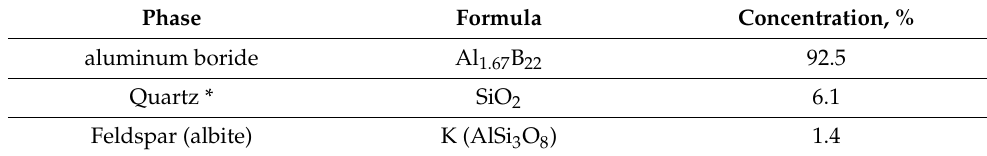
Table 8. Results of semi-quantitative X-ray phase analysis of slag.